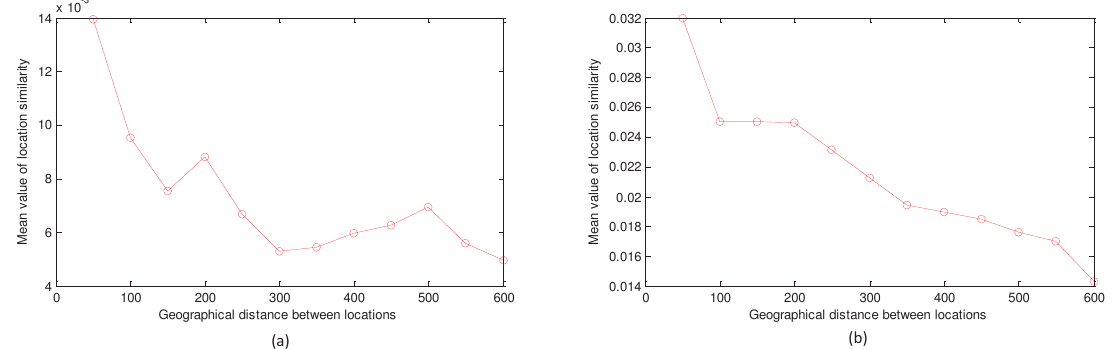
Figure 4. Relationship between geographical distance and POI similarity in the ( a ) Gowalla and ( b ) Brightkite